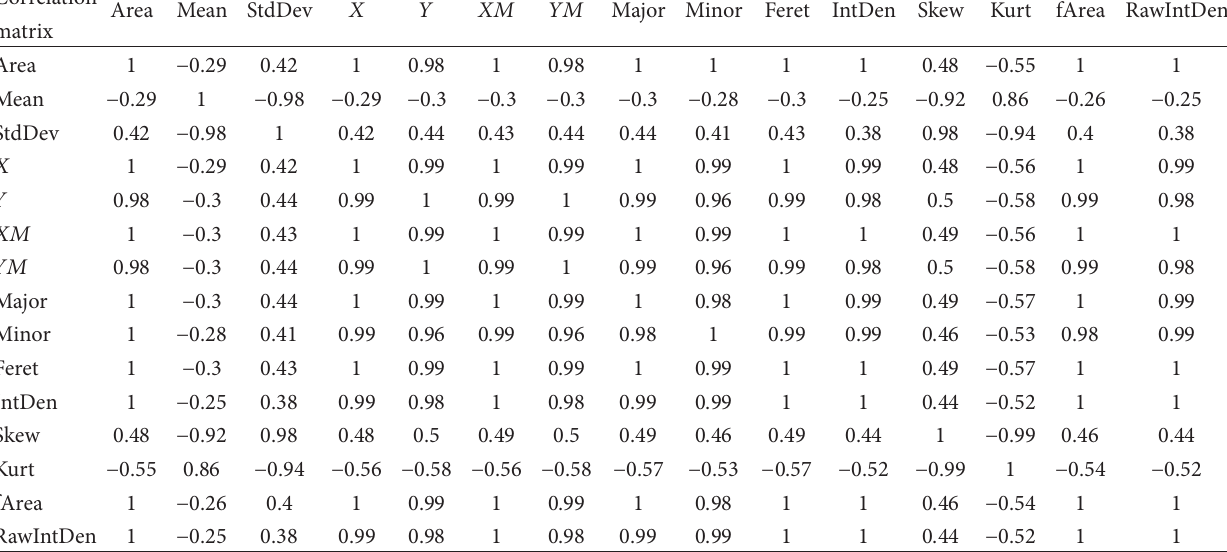
Table 8: Correlation matrix (PCA).